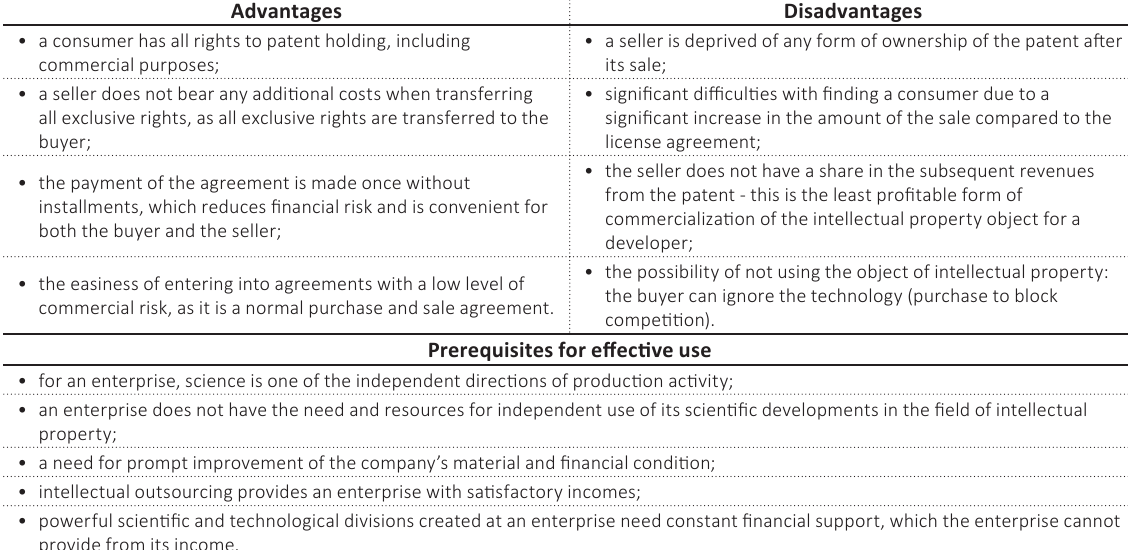
Table 2. Economic prerequisites of horizontal commercialization of intellectual property objects